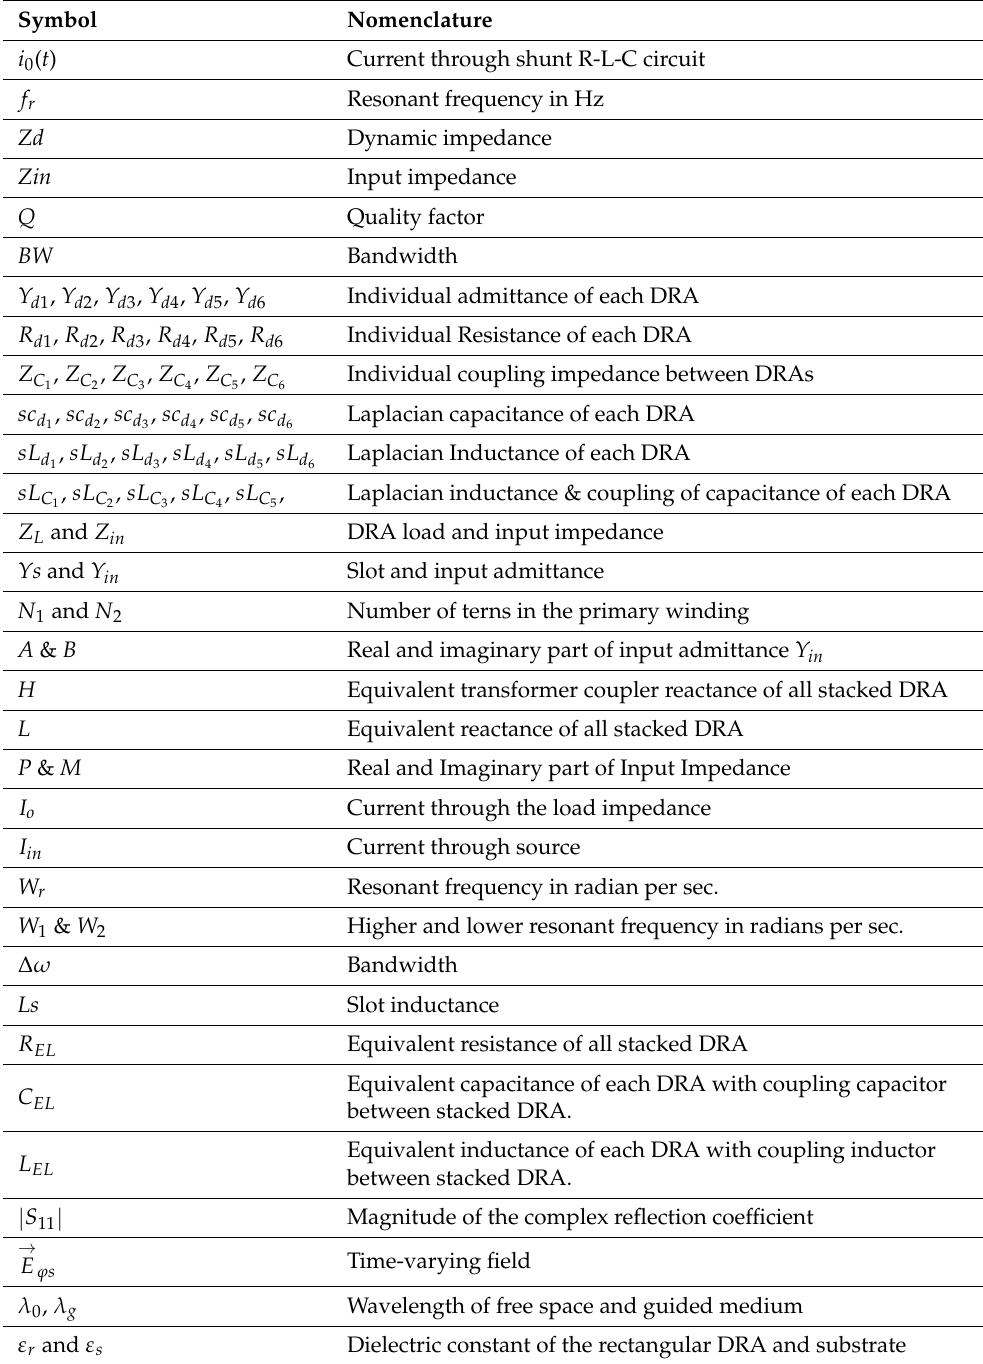
Table 2. Used symbols in mathematical modeling with their Nomenclature.